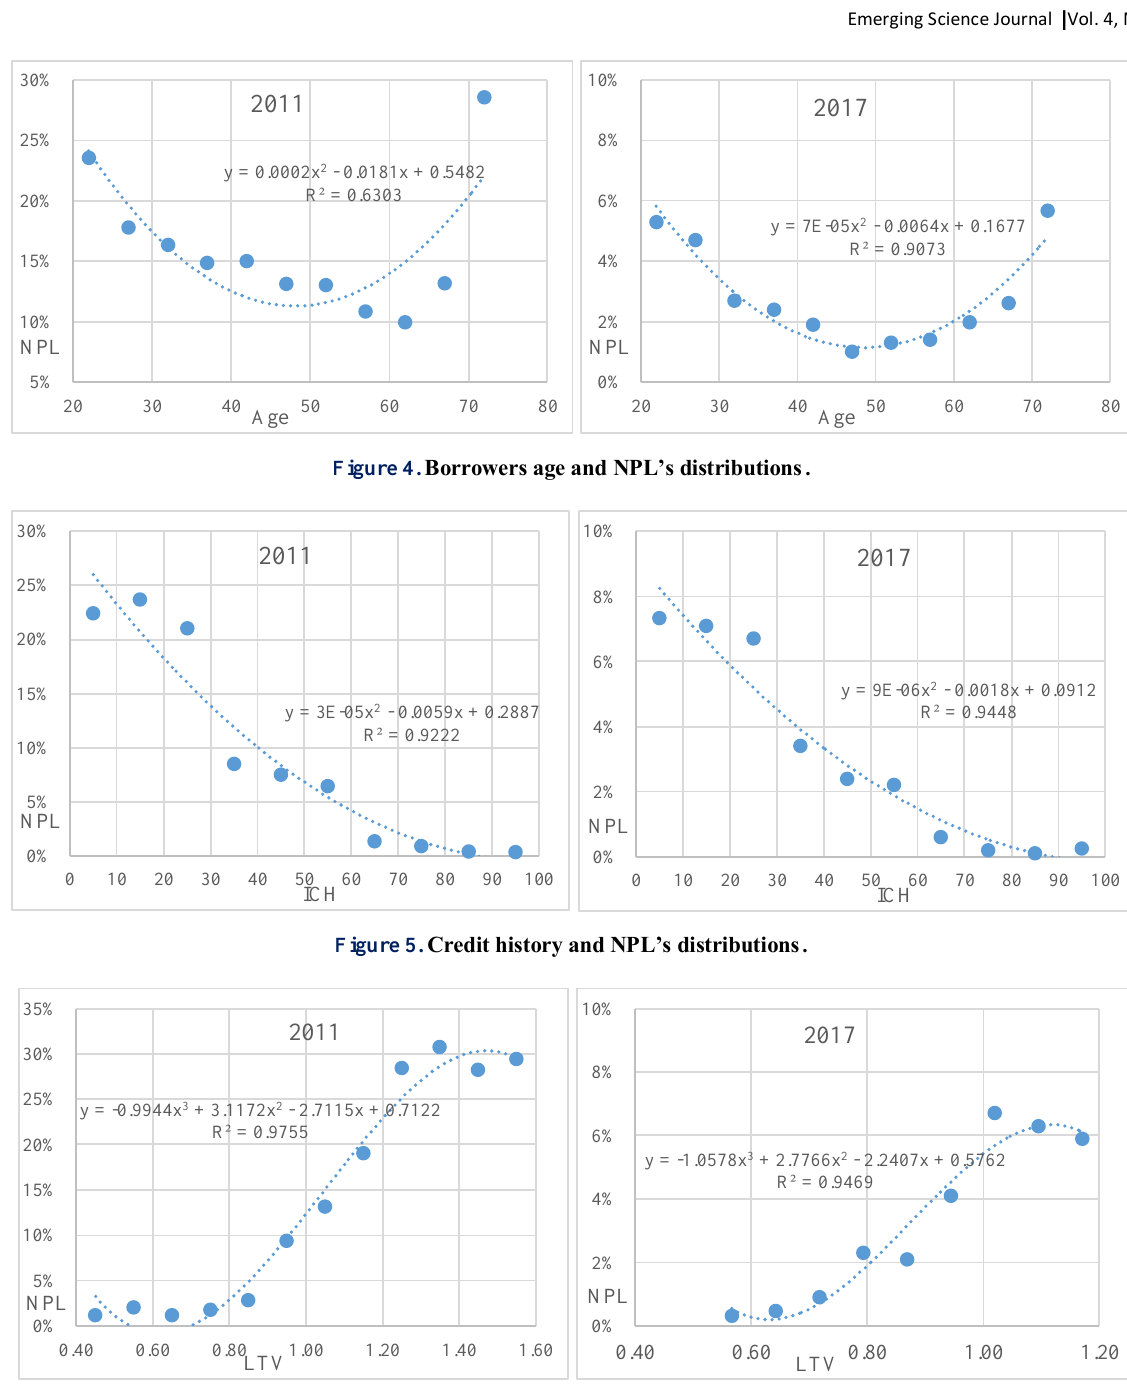
Figure 6. LTV’s and NPL’s distributions.